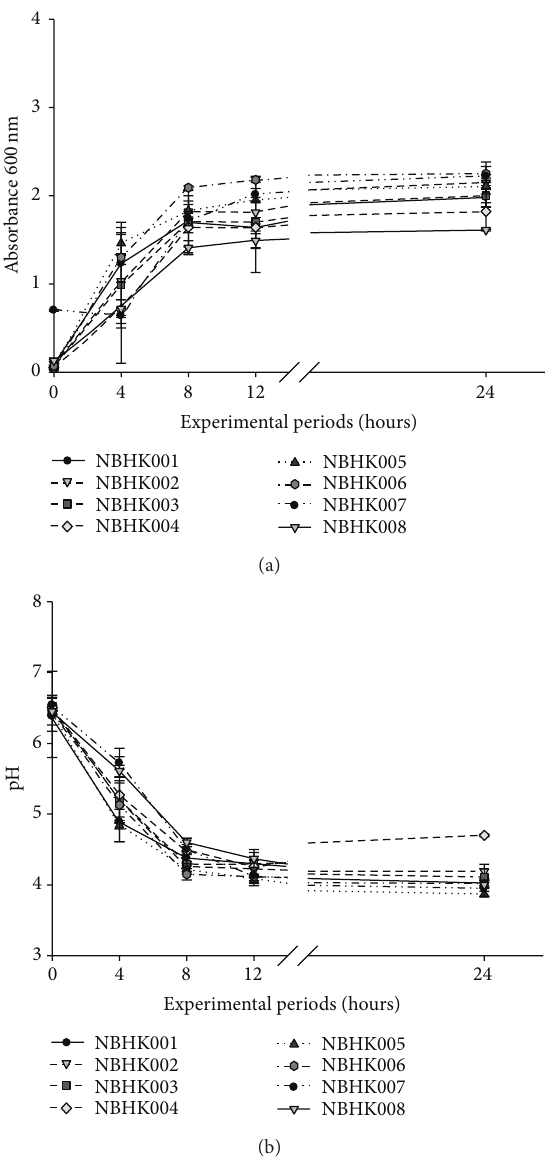
Figure 2: (a) Growth curve of screened probiotics cultured in MRS broth containing TCA. (b) Change in pH value of screened probiotics cultured in MRS broth containing TCA.